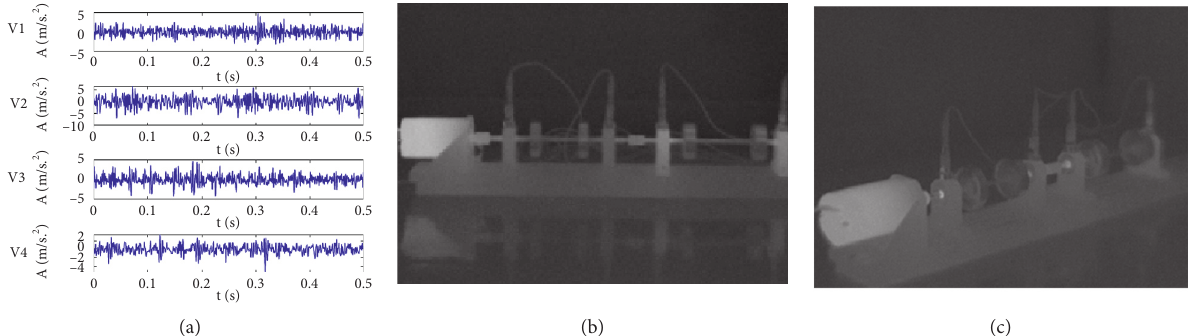
Figure 7: Sample data obtained in the experiments: (a) 4 vibration signals from different measuring points, (b) infrared image in Case 1, and (c) infrared image in Case